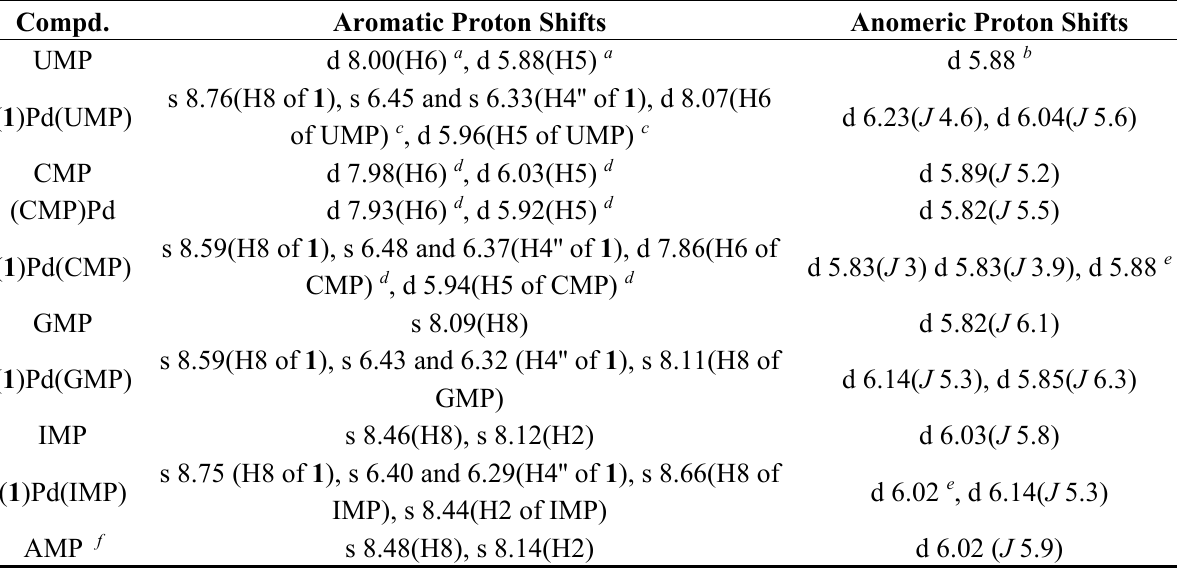
Table 2. Chemical shifts for the aromatic and anomeric protons of the mixed ligand Pd 2+ complexes of